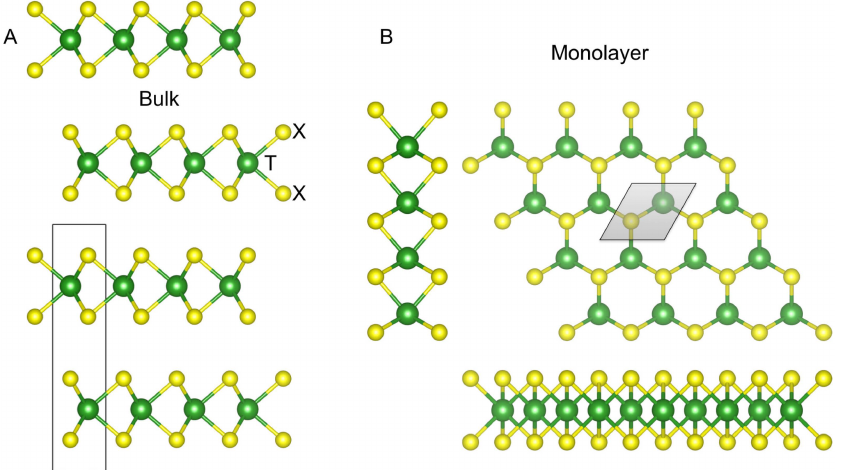
Figure 1. The atomic structure of transition-metal dichalcogenides of the 2 H TX 2 type (T, transition metal; X, chalcogenide). ( A ) Bulk and ( B ) monolayer systems are shown together with their unit cells. Different sheets of TX 2 are composed of three atomic layers X ´ T ´ X, where T and X are covalently bonded. Sheets are held together by weak van der Waals